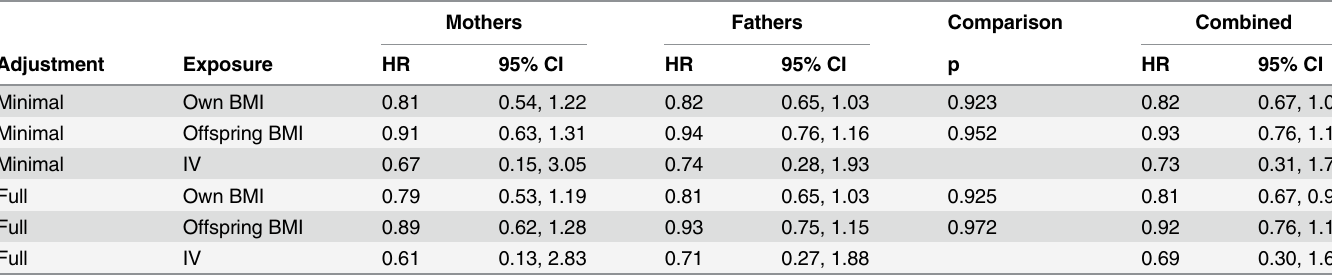
Table 5. Hazard ratios for suicide mortality per sex-specific SD of body mass